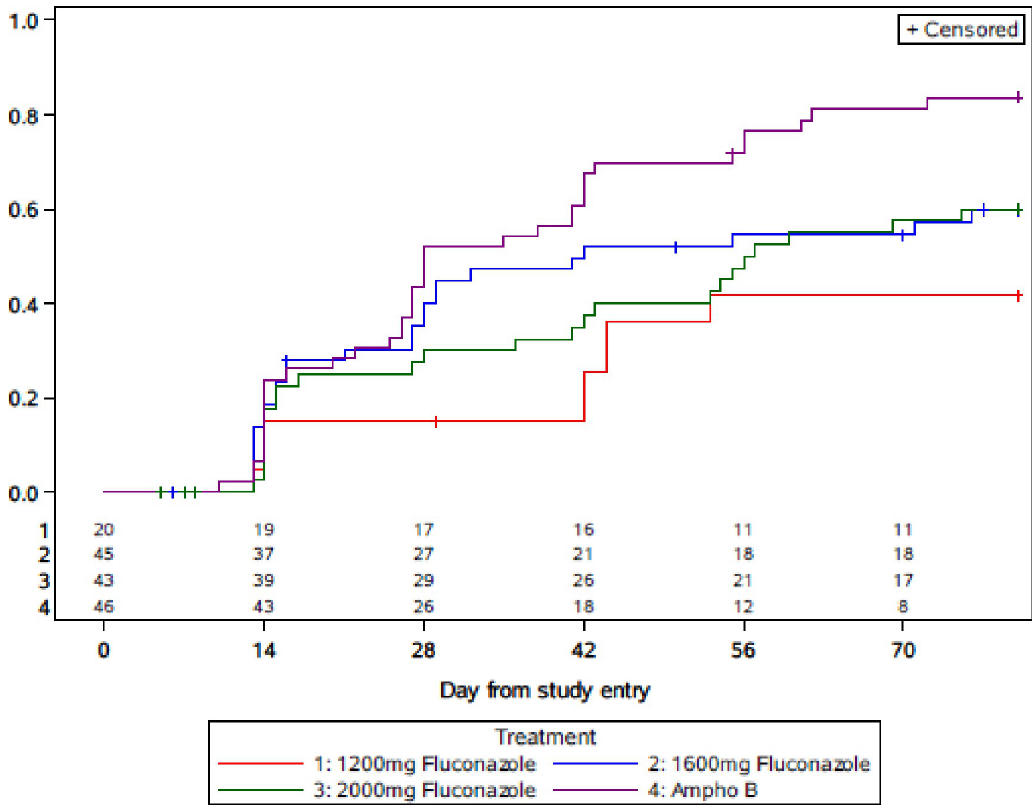
Fig 2. Time to negative CM culture. � In the 1600mg FZ arm, 4/45 subjects switched to Ampho B and culture converted by week 10, An additional 5/45 started ampho B and subsequently died. In the 2000mg FZ arm 5/43 subjects switched to Ampho B and culture converted by week 10. An additional 3/43 started ampho B and subsequently died. In the Ampho B arm, 1/46 subjects switched to Fluconazole and culture converted by week 10.